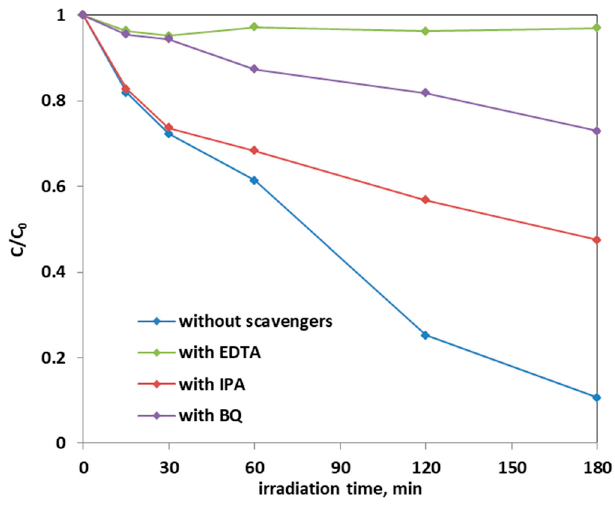
Figure 16. Effect of the scavenger molecules for the degradation of AO7 aqueous solution using 0.3 g of optimized Fe(2.5)-TiO 2 photocatalyst under visible-light irradiation.